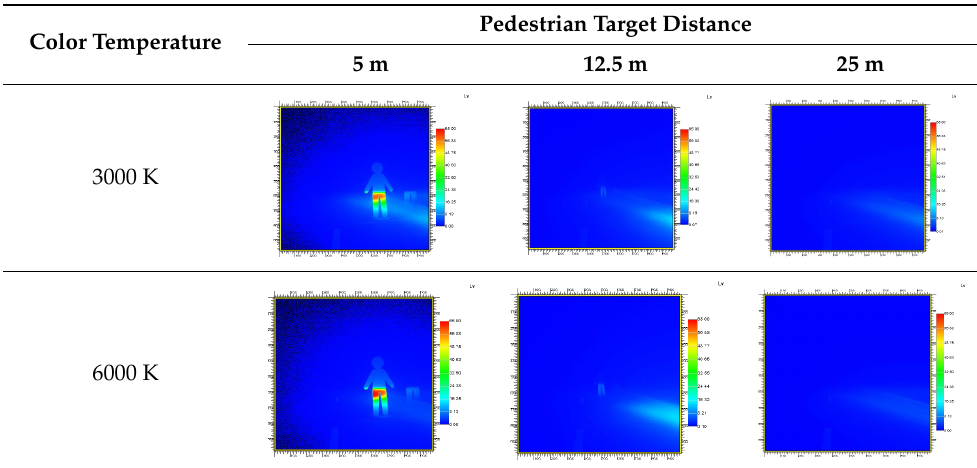
Table 8. Comparison of luminance by target distance and color temperature (fog 40